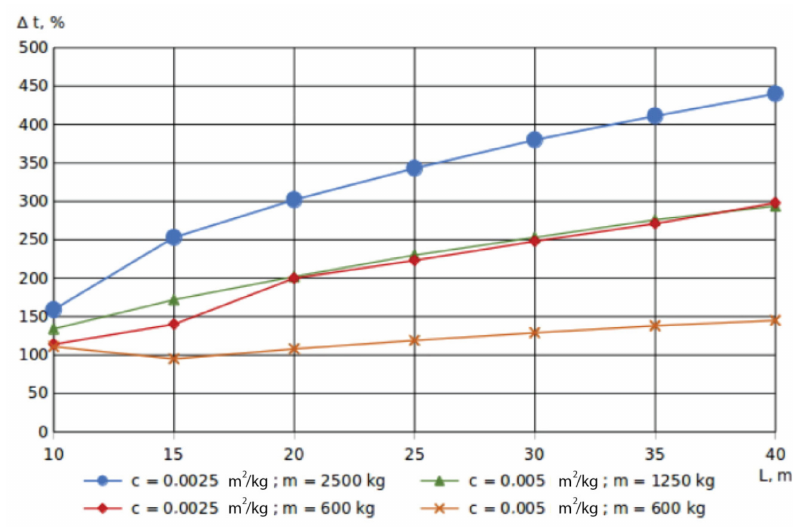
Figure 6. Influence of cable length on transient